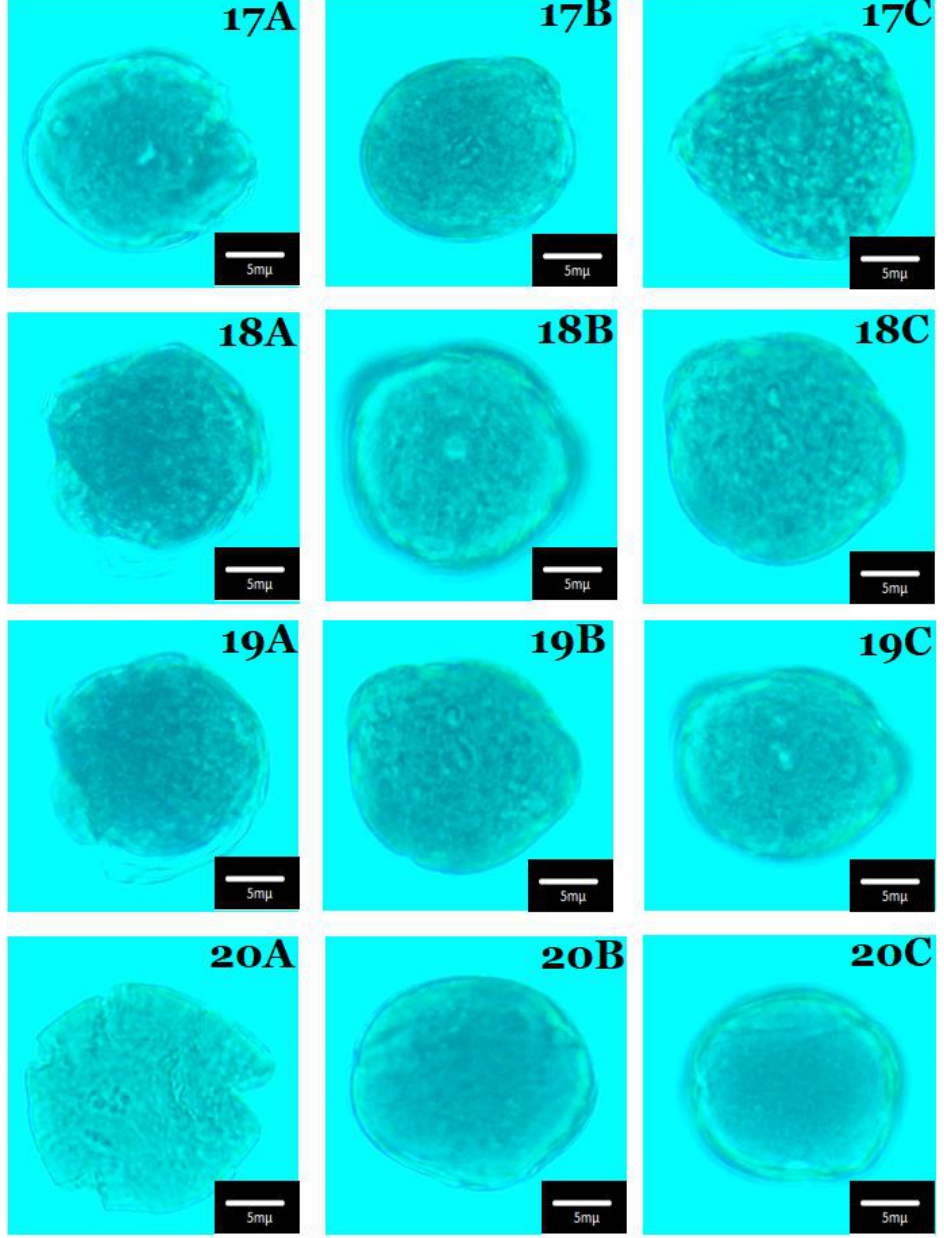
Figure 6. Light microscopy micrographs of R. sericea ( 17A – 17C ), R. omeiensis ( 18A – 18C ), R. sikangen-